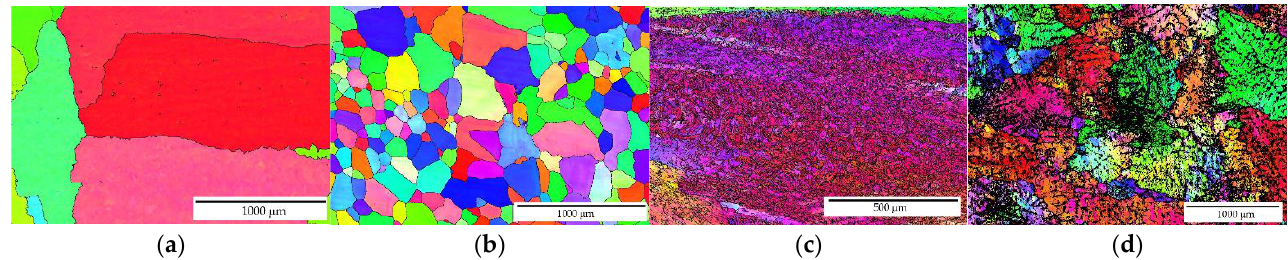
Figure 1. EBSD images of the structure of grains ( a ) AlYb AC, ( b ) AlMnYbZr AC, ( c ) AlYb CR40, ( d ) AlMnYbZr CR70.